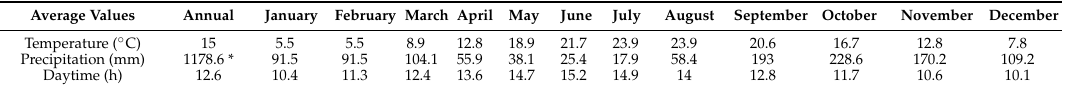
Figure 4. Annual temperature (°C) in Rasht County. Table 2. Monthly weather average (2014).